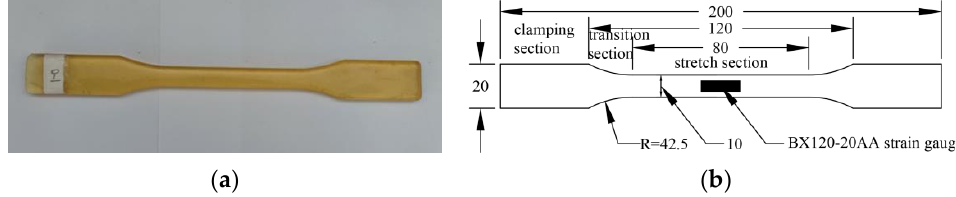
Figure 2. Epoxy resin adhesive sheet: ( a ) sheet and ( b ) size and position of strain gauge.